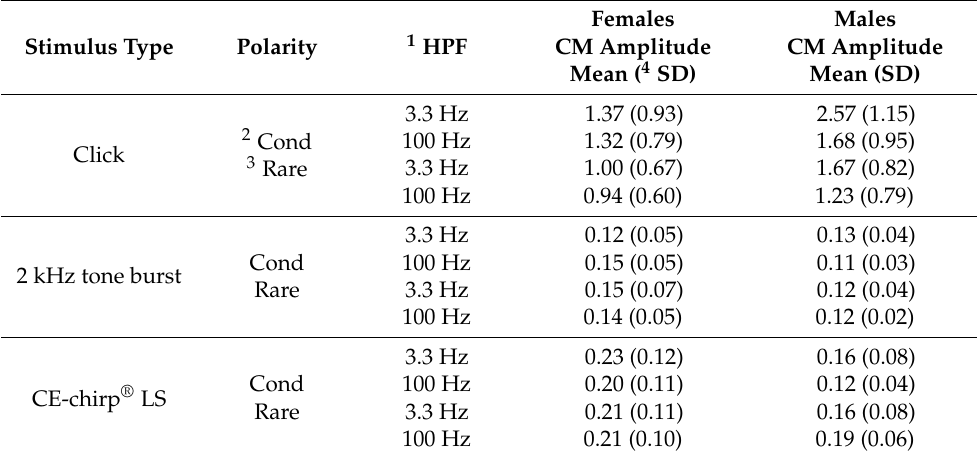
Table 4. Means and standard deviations of CM amplitudes (in nV) evoked by click, 2 kHz tone burst and CE-chirp ®